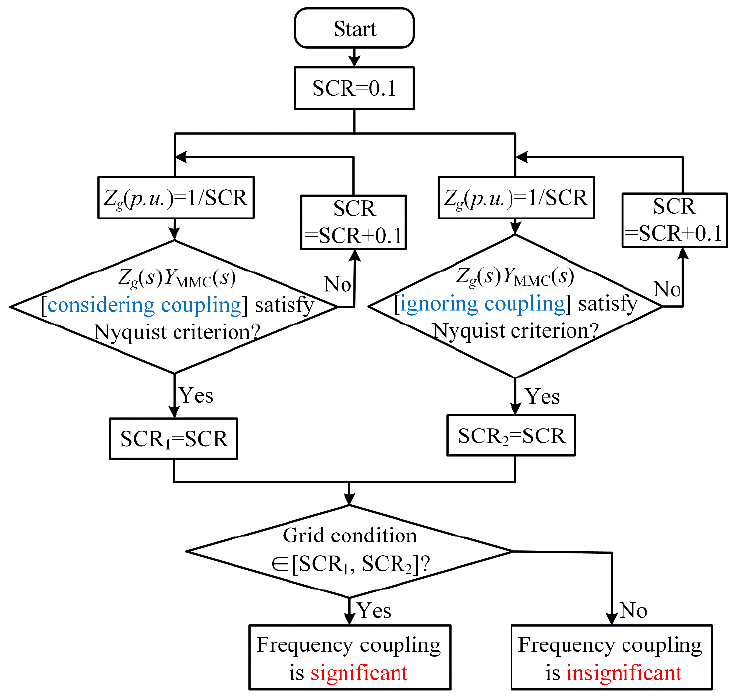
Figure 10. Flow chart for significance evaluation of frequency coupling.